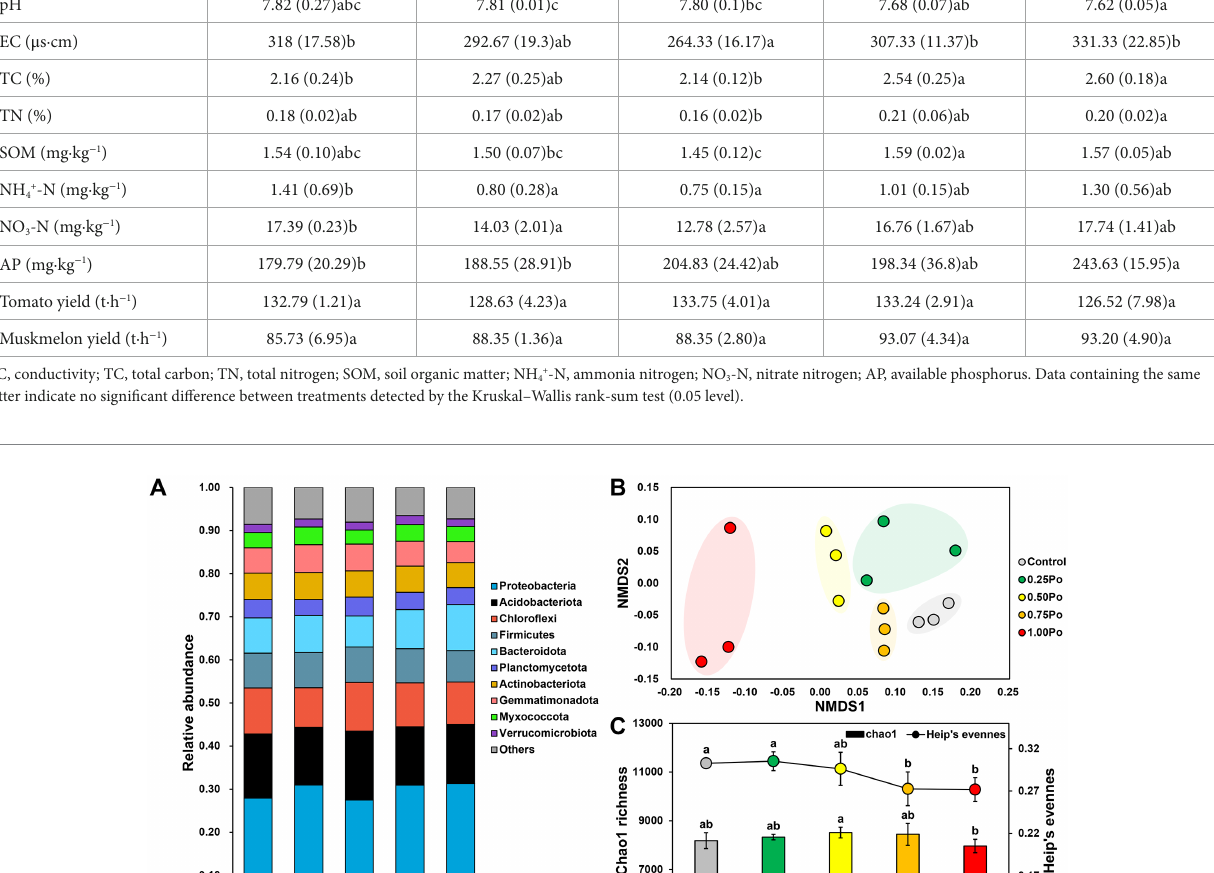
TABLE 1 Soil properties under different treatments. Property